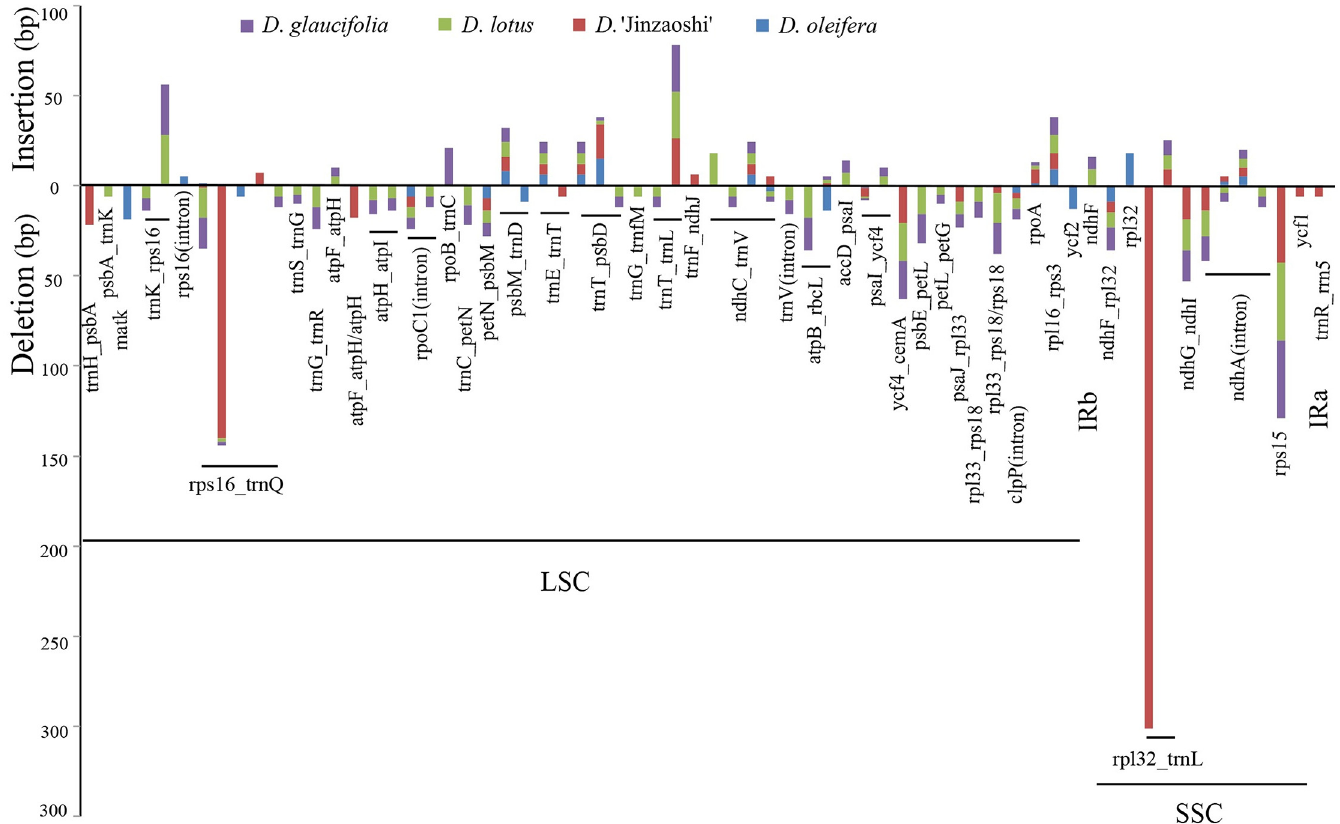
Fig 4. Indels ( (cid:1) 5 bp) identified based on multiple sequence alignment of five Diospyros cp genomes. Insertions are shown above and deletions below the horizontal axis. Indel distribution was positioned using D. kaki as a reference.